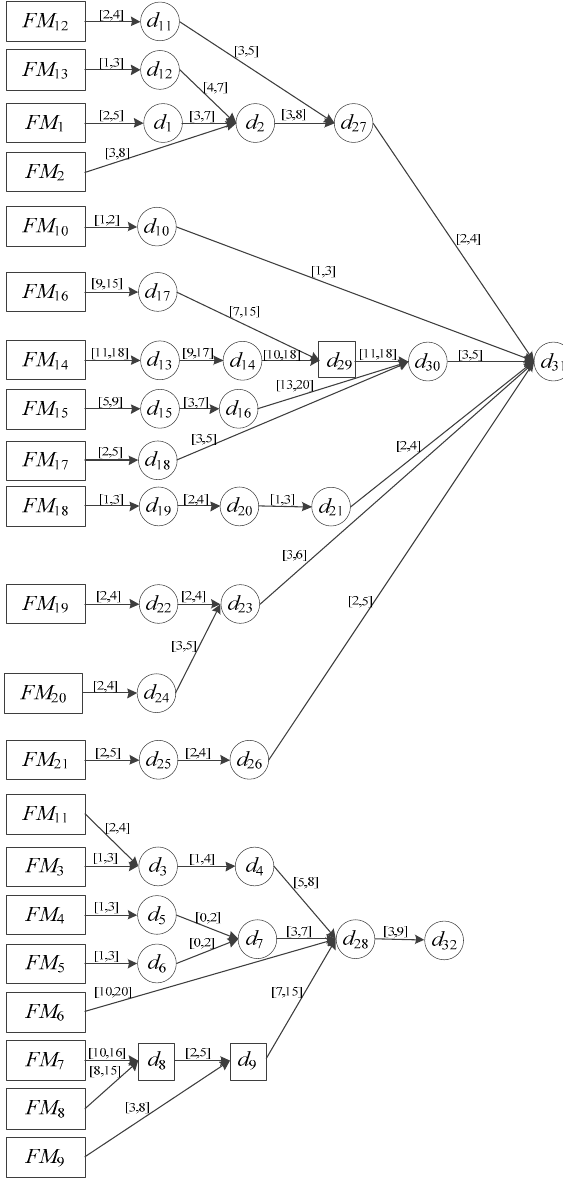
Figure 7. TFPG model of the electromechanical actuator.